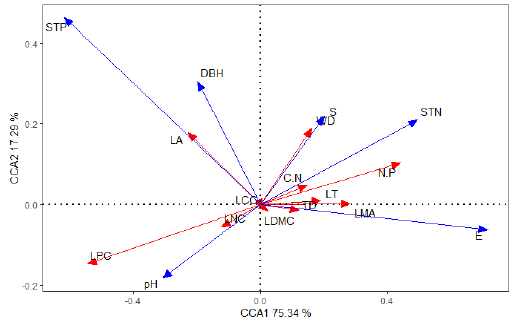
Figure 3. Canonical correspondence analysis (CCA) of the functional traits and influencing factors of L. fragrantissima var . lancifolia . The red solid lines represent functional traits and the blue solid lines represent the influencing factors. The length of the arrow represents the degree of correlation between a certain influencing factor or plant growth index and plants. The angle between the arrows indicates the correlation of the influencing factors. Influencing factors abbreviations: STP (soil total phosphorus); STN (soil total nitrogen); E (elevation); S (slope). Trait abbreviations: LT (leaf thickness); LDMC (leaf dry matter content); LA (leaf area); LMA (leaf mass per unit area); TD (leaf tissue density); WD (wood density); LNC (leaf nitrogen content); LCC (leaf carbon content); LPC (leaf phosphorus